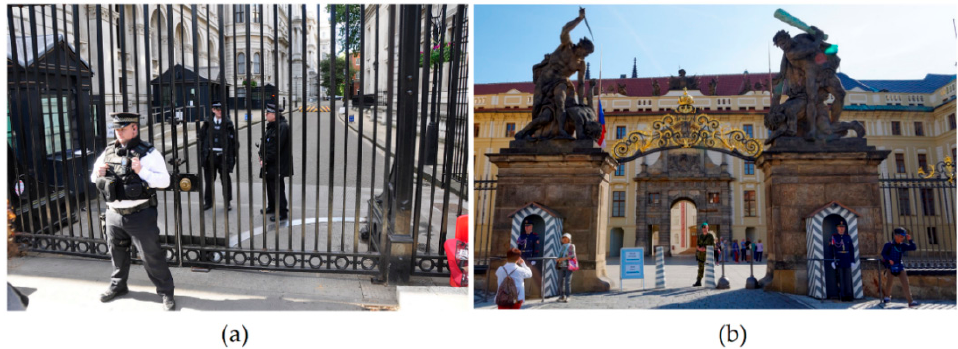
Figure 3. Establishing safety zones via checkpoints: ( a ) the seat of the British Prime Minister in London. ( b ) The Hrad č any castle complex in Prague; phot. ATG Access Ltd., 2015.